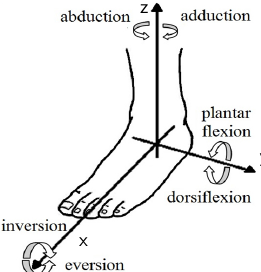
Figure 1: The Ankle joint anatomy.